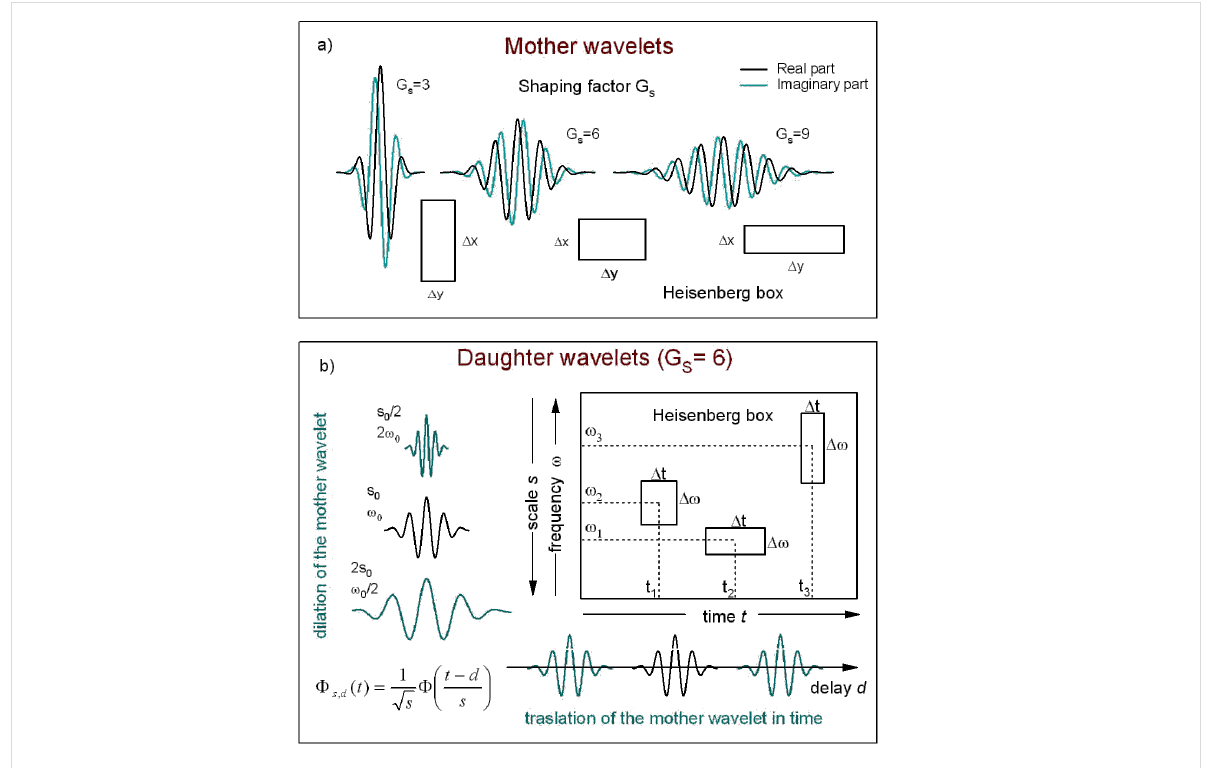
Figure 4: a) Complex Gabor wavelet with different shaping factors. An increase of G S corresponds to more oscillations under the envelope. The "Heisenberg box" shows the relationship between the time and frequency resolution, like the uncertainty principle in quantum mechanics (adapted from [15]). b) A graphical representation of the delay and dilation transformations used in the continuous wavelet transform (adapted from [16]).